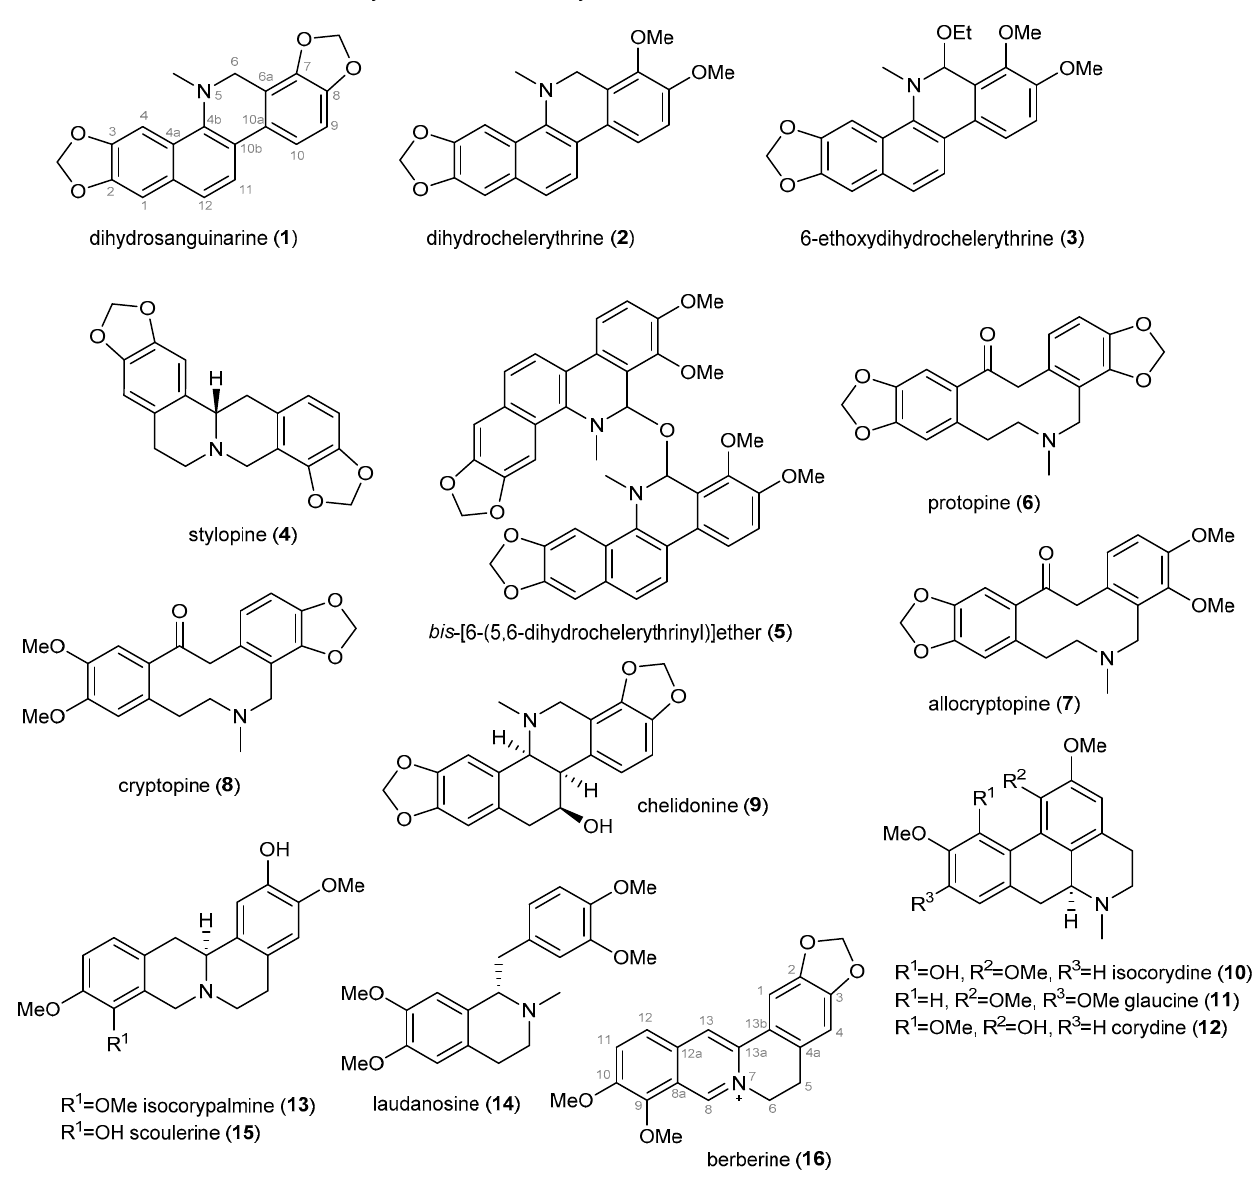
Figure 1. Isoquinoline alkaloids isolated from the whole plant of Dicranostigma franchetianum . Table 1. In vitro antimycobacterial activity against Mtb H37Ra, Mycolicibacterium aurum , Mycobacte- rium avium , Mycobacterium kansasii , and Mycolicibacterium smegmatis (MIC), cytotoxicity (IC 50 ), selec- tivity index (SI), and calculated lipophilicity (ClogP) of isoquinoline alkaloids and berberine deriv- atives.